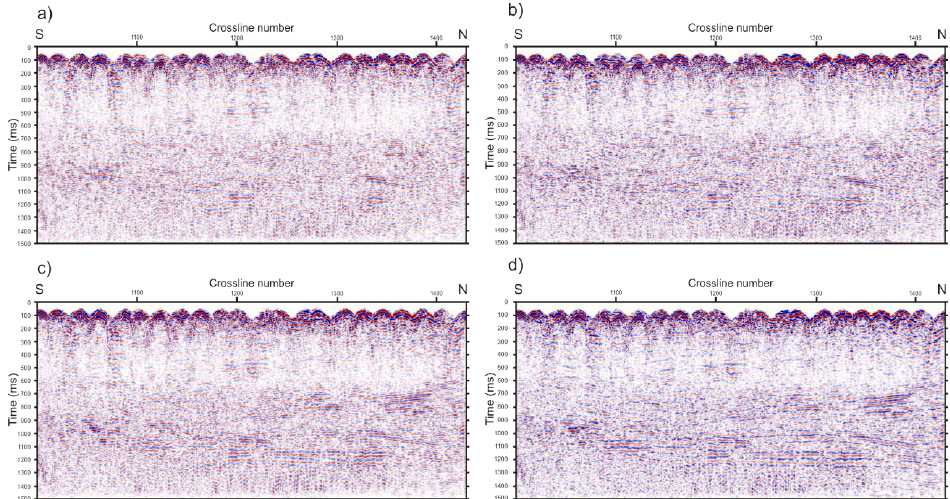
Fig. 8. (a) Raw inline 1050; (b) same as (a) with the source wavelet matching based on time and phase shifting applied; (c) same as (a) with elevation and refraction statics applied; (d) same as (a) with source wavelet matching, elevation and refraction statics applied. The location of inline 1050 is marked in Fig. 2 .